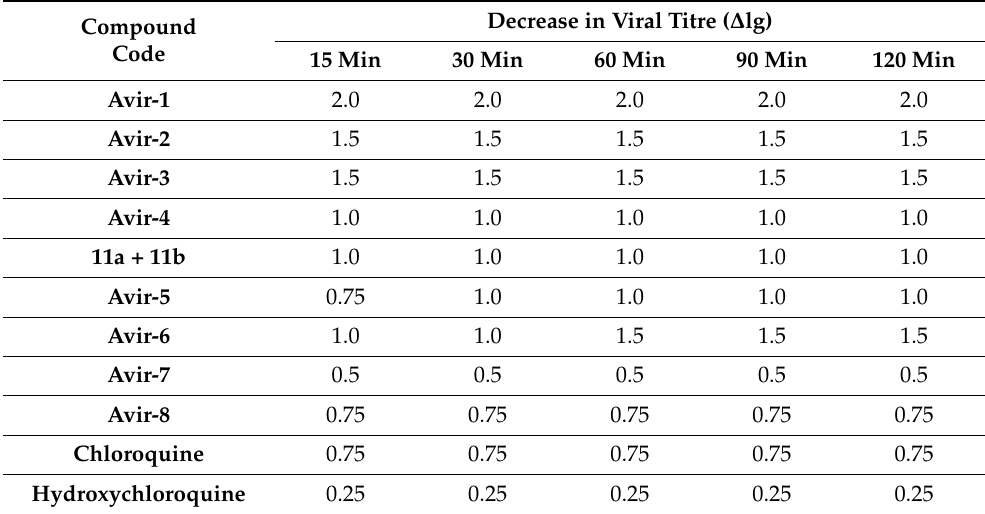
Table 4. Pre-treatment of healthy MRC-5 cells with heterocyclic compounds and subsequent infection with coronavirus strain 229E.